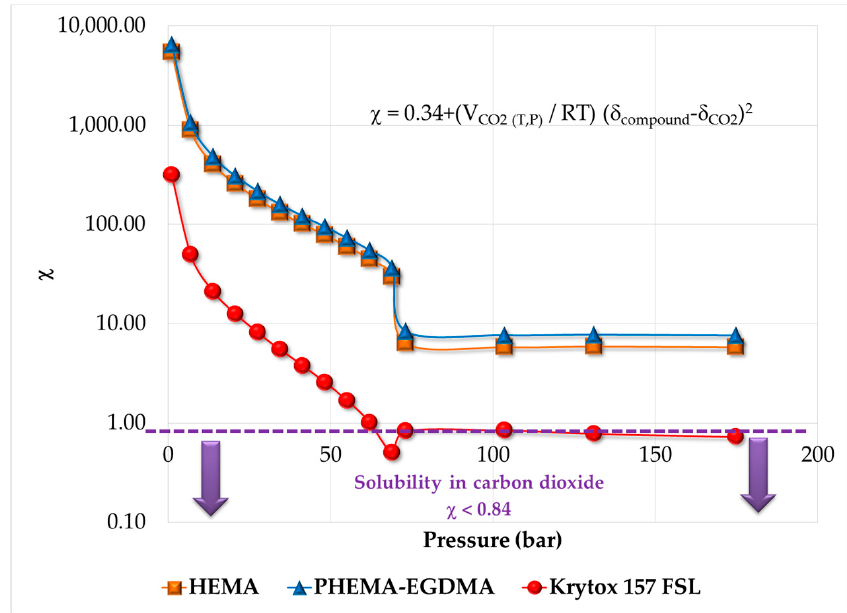
Figure 3. Solute-solvent Flory interaction parameter, χ , versus pressure, for solutes HEMA, polymer network and Krytox 157 FSL, in CO 2 (solvent). A solute is soluble in the solvent when χ < 0.84.